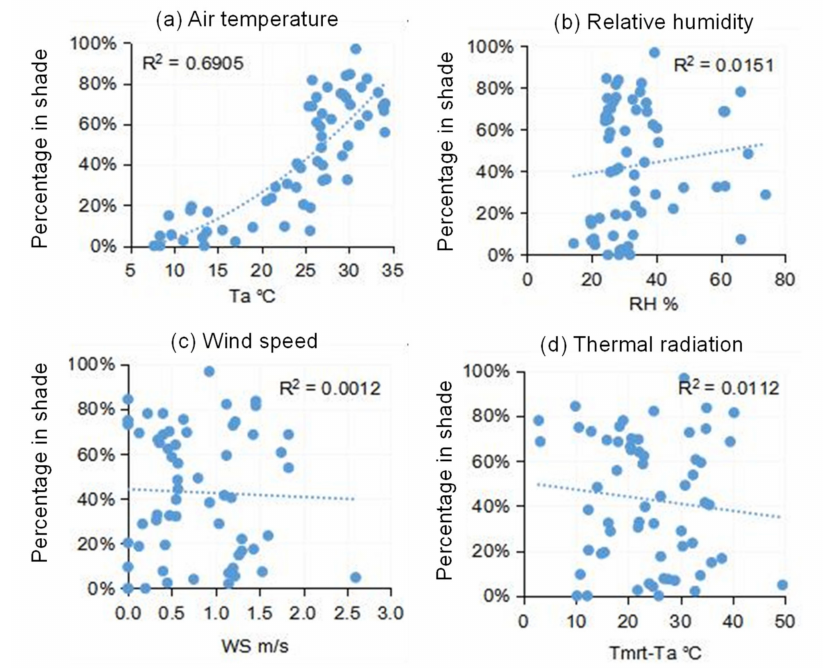
Figure 11. The percentage of people walking in shade with respect to T a , RH , WS , and T mrt − T a